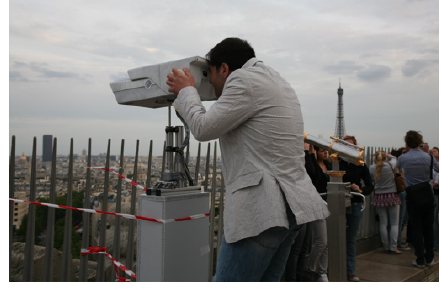
Fig. 7. A tourist looking in our Telescope (version beta).